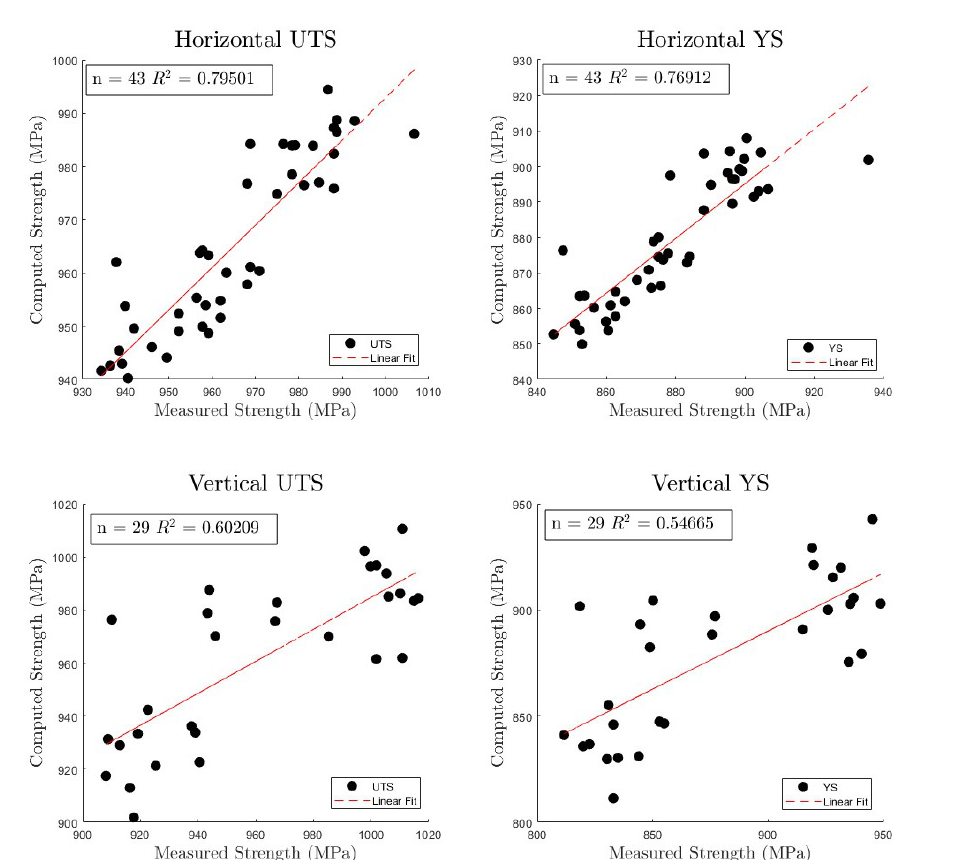
Figure 7. Predicted versus measured UTS and YS (MPa) for the NP3 horizontal and vertical